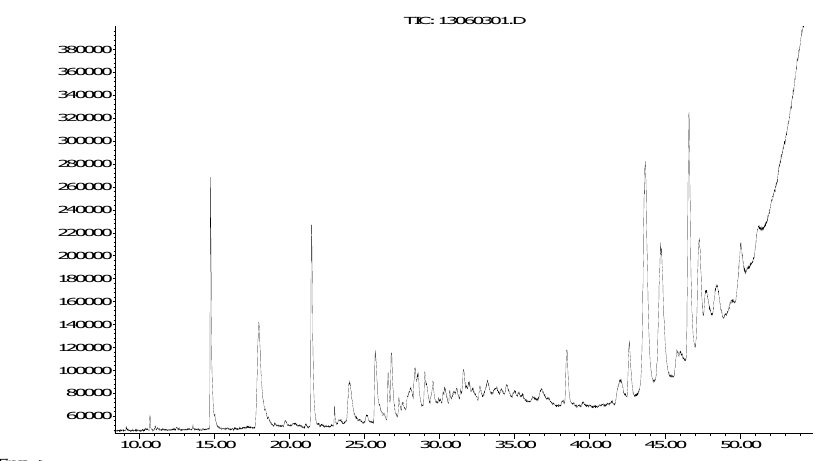
Figure 2. Total ion chromatogram of the agarwood